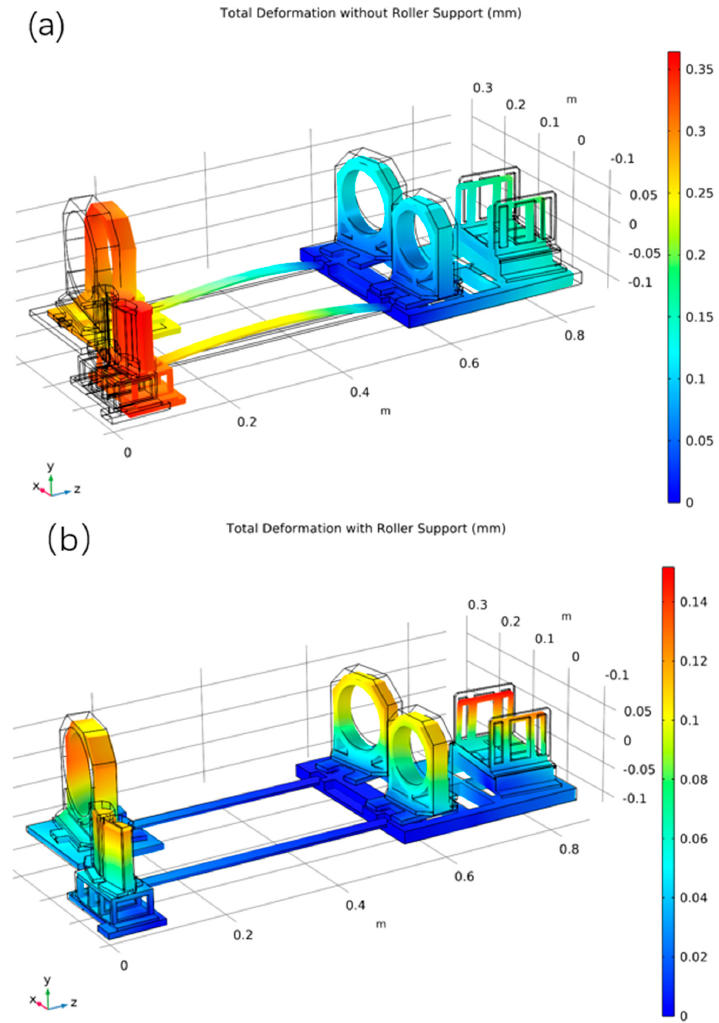
Figure 14. Comparison of thermal simulation results of the two support methods (the initial temperature is 20 ◦ C, and the temperature change is 40 ◦ C): ( a ) Fixed support at both ends; ( b ) Fixed support at one end and rolled support at the other end.